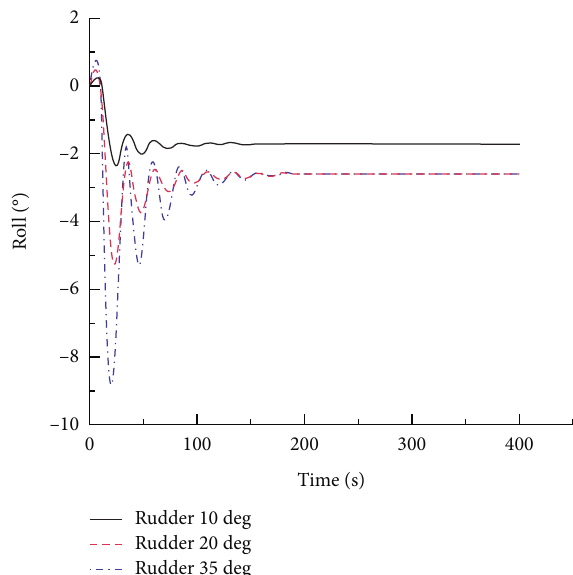
Figure 10: Ship’s transverse change curves for different rudder angles.